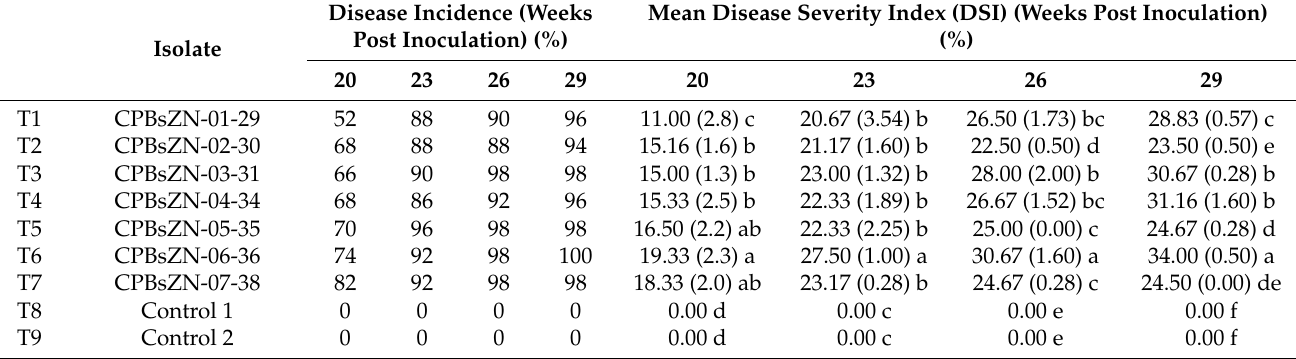
Table 2. Severity index in plants inoculated with Ganoderma zonatum .